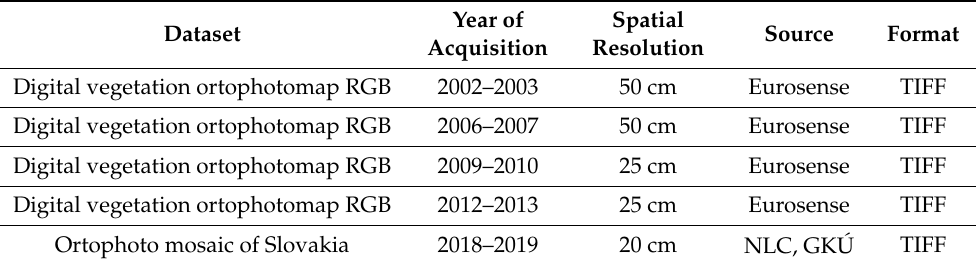
Table 2. Description of the source data for interpretation of land cover at a scale 1:10,000. Dataset